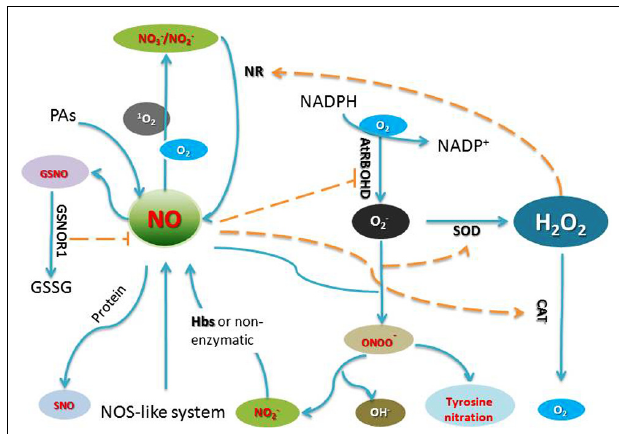
FIGURE 1 | Generation of and crosstalk by RNS and ROS in plant cells. AtRBOHD, an NADPH oxidase; GSNO, S -nitrosoglutathione; GSNOR1, S -nitrosoglutathione reductase 1; GSSG, glutathione disulfide; NR, nitrate reductase; SOD, superoxide dismutase; Hbs, Hemoglobin; PAs, polyamines; CAT, catalase.